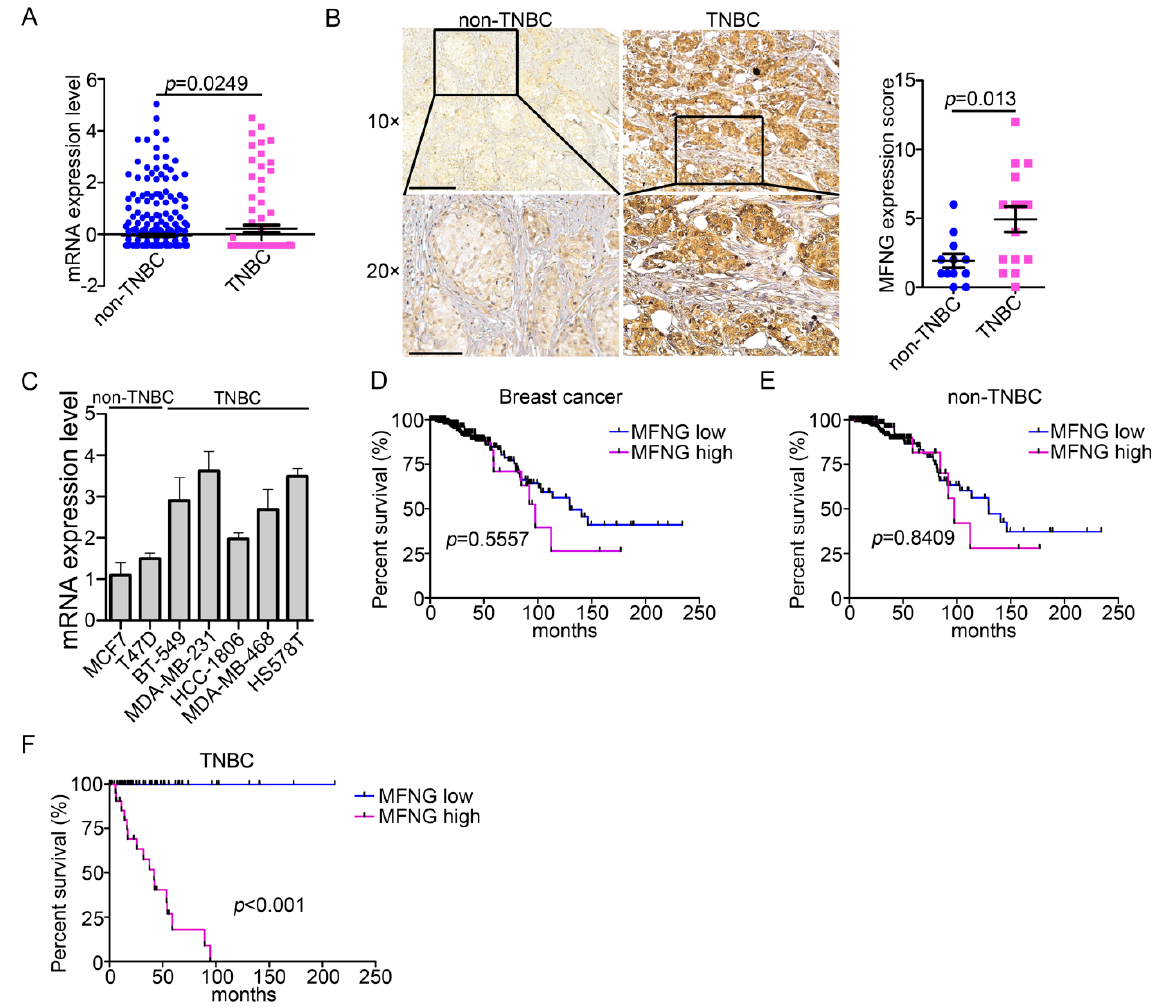
Figure 1. MFNG expression was significantly increased in TNBC tissues and positively associated with the poor prognosis of TNBC patients. ( A ) Based on the TCGA data (nature, 2012), we inves- tigated the MFNG expression in TNBC ( n = 389) and non-TNBC ( n = 90) breast cancer samples. ( B ) Immunohistochemistry assay was used to assess the MFNG protein level in TNBC ( n = 15) and non-TNBC ( n = 12) breast cancer tissues ( left ), and the result of statistical analysis was shown ( right ). ( C ) MFNG mRNA expression level was examined in TNBC and non-TNBC cells in RT- qPCR, data representing the mean ± SD of three replicates. According to the MFNG expression level (Z-score) in breast cancers samples (TCGA, nature, 2012), patients were divided into MFNG low (Z-score ≤ − 0.4319) and high (Z-score > − 0.4319) expression groups. We analyzed the overall survival of breast cancers ( D ), non-TNBC ( E ), and TNBC ( F ) samples by using the Kaplan–Meier method, breast cancer (MFNG low, n = 358; MFNG high, n = 121; p = 0.5557), non-TNBC (MFNG low, n = 292; MFNG high, n = 99; p = 0.8409), and TNBC (MFNG low, n = 68; MFNG high, n = 23; p < 0.001). Survival curves were plotted by the Kaplan–Meier method and analyzed by the log-rank test. Statistical analyses were analyzed using a Student’s t